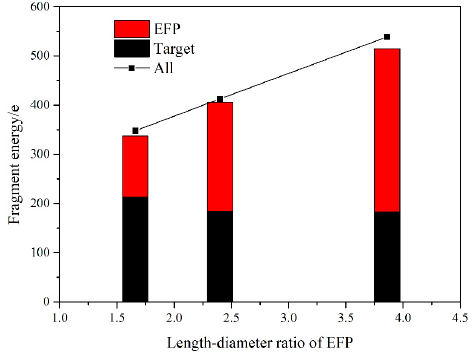
Figure 10. Total energy of the BAD of EFPs with different L / D s.